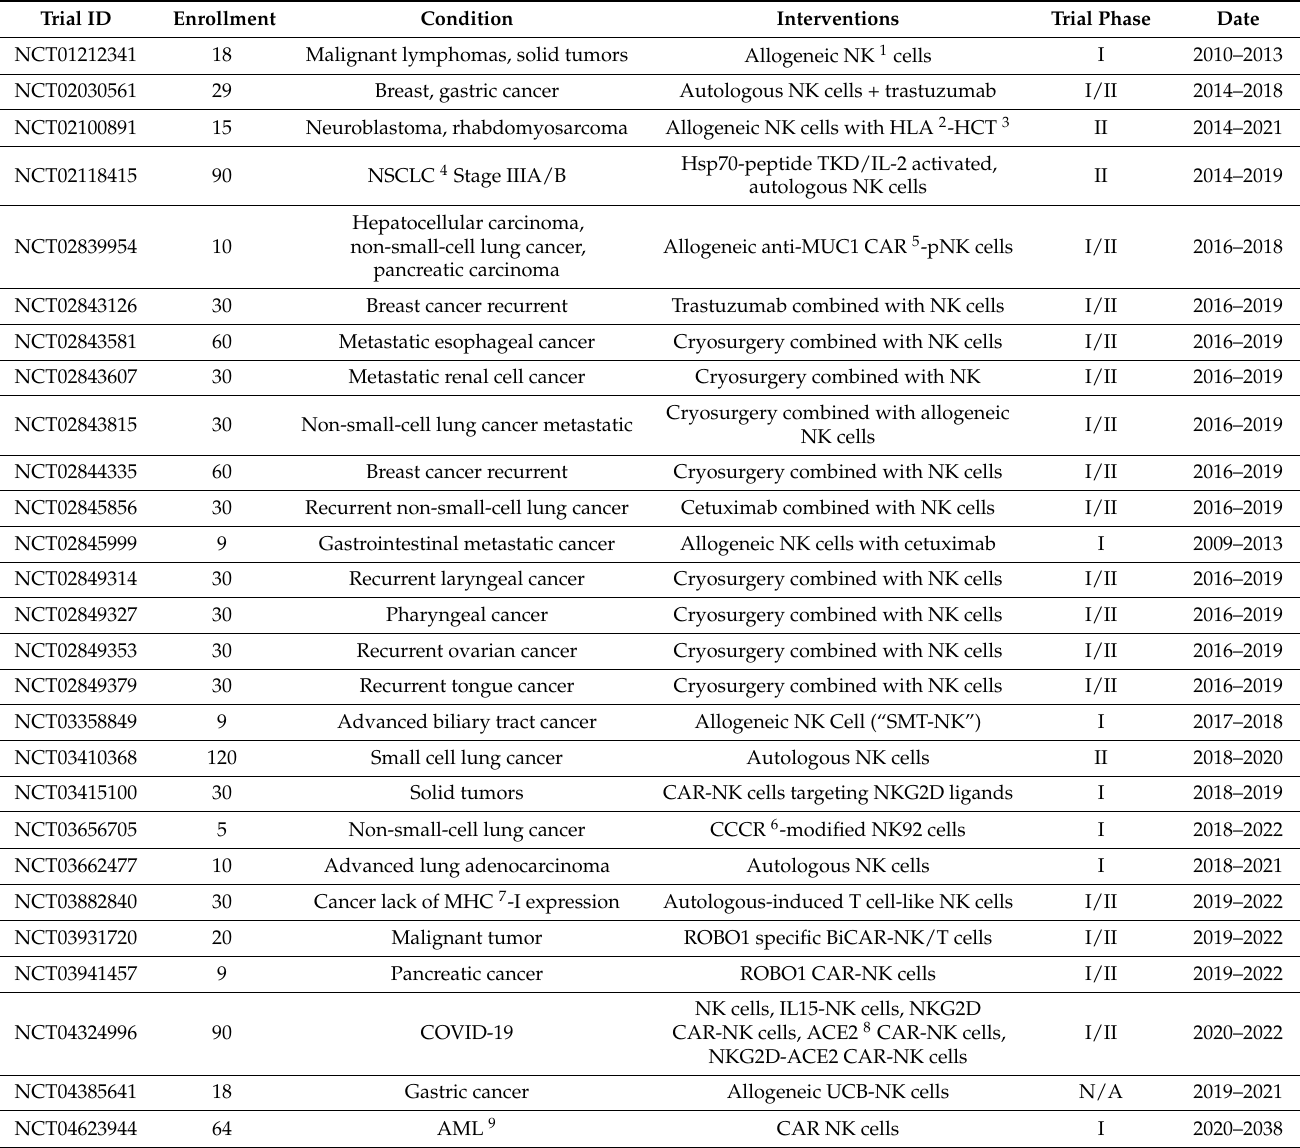
1 NK—natural killer; 2 HLA—human leukocyte antigen; 3 HCT—haploidentical hematopoietic cell transplantation; 4 NSCLC—non-small- cell lung cancer; 5 CAR—chimeric antigen receptor; 6 CCCR— chimeric costimulatory converting receptor; 7 MHC—major histocompatibil- ity complex; 8 ACE2—angiotensin-converting enzyme 2; 9 AML—acute myeloid